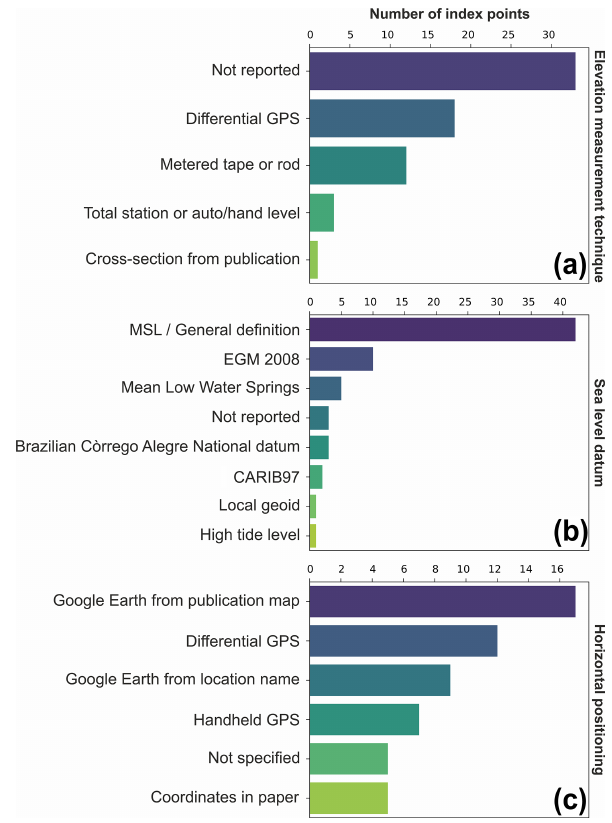
Figure 2. Frequency of elevation measurement techniques (a) , da- tums (b) , and horizontal positioning techniques (c) used in the